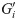
Mapping into a weighted matching problem.Left: intermediate step where Gi′ is built. On the leftmost part we show an example of several communications passing along (ij) and exiting along the remaining neighbors k ∈ ∂i \ j. Right: the final step where Gijl′′ is built; the best configuration around node i when the blue current passes through (ij) is given by the minimum weighted matching on the complete auxiliary graph Gijl′′. Edges red and green represent the best matching, i.e. the configuration where two other communications enter/exit neighbors of i \ j.